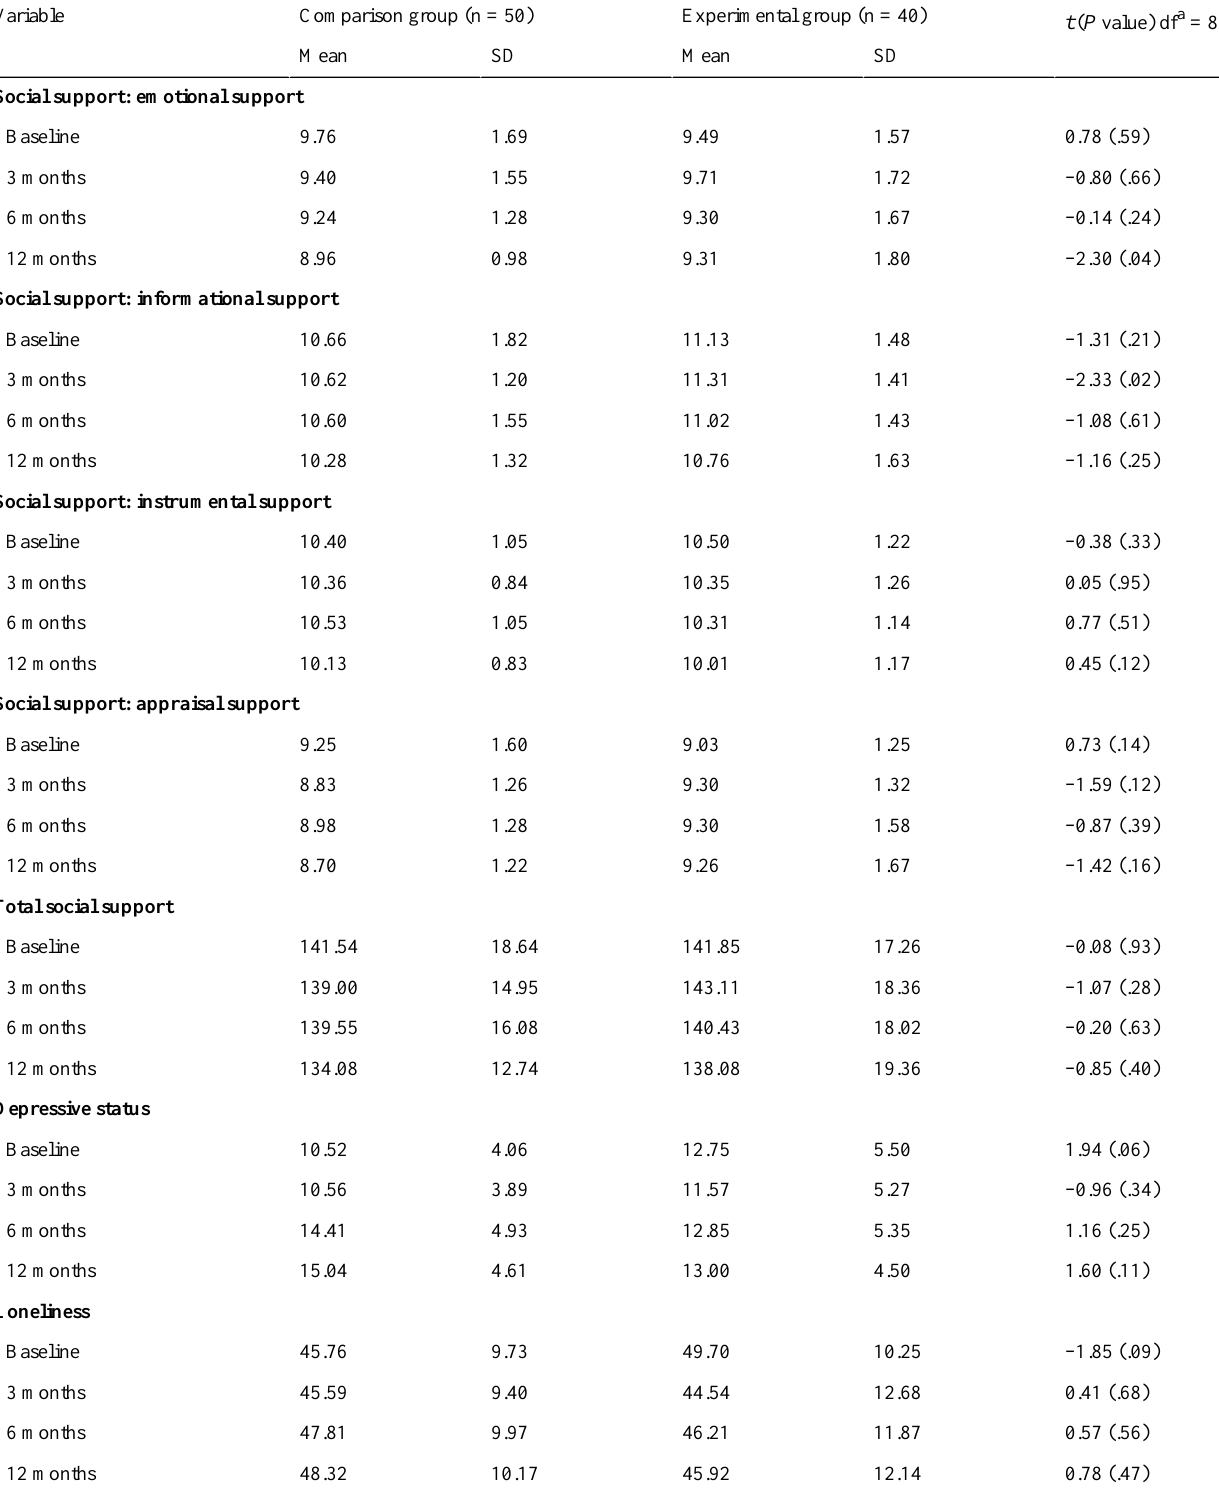
Table 2. Social support (Social Support Behaviors Scale), depressive status (Geriatric Depression Scale), and loneliness (University of California Los Angeles Loneliness Scale) scores by group at baseline, and 3, 6, and 12